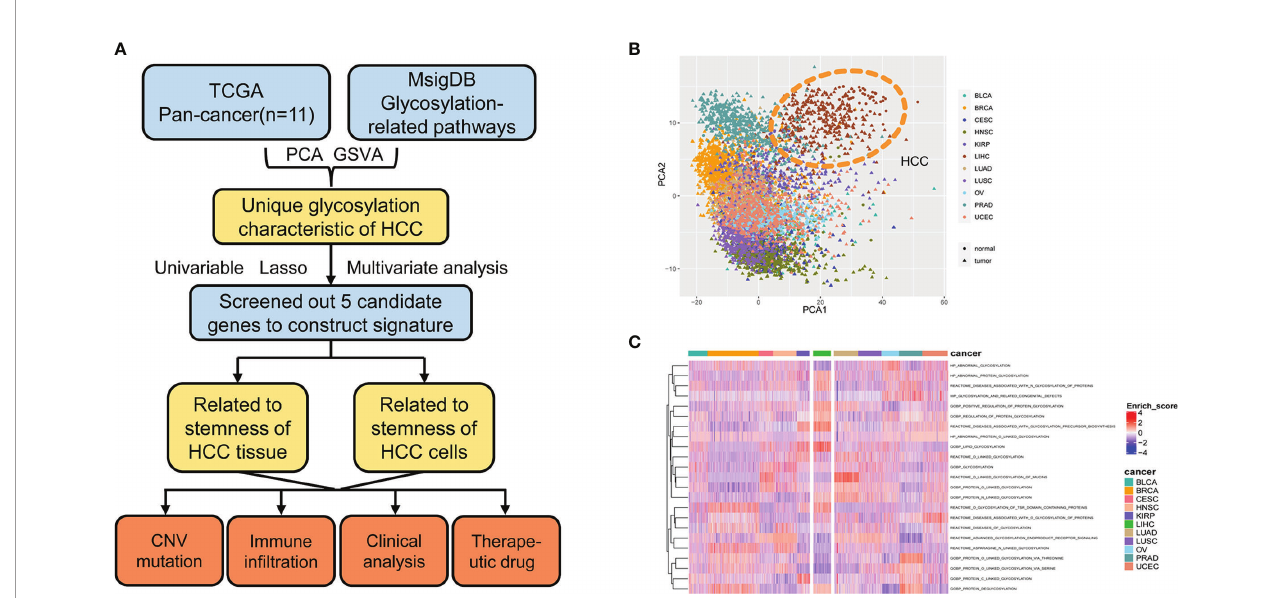
FIGURE 1 | Glycosylation alterations in human pan-cancer. (A) Study fl owchart. (B) PCA projection of paired tumor and normal tissue samples from 11 different cancer types in TCGA. Different colors represent different cancer types. Circles and triangles represent normal and tumor tissue, respectively. (C) Heatmap showing glycosylation-related pathway alterations across 11 cancer types. MsigDB, molecular signatures database; PCA, principal component analysis; HCC, hepatocellular carcinoma; GSVA, gene set variance analysis; CNV, copy number variation; BLCA, bladder urothelial carcinoma; BRCA, breast invasive carcinoma; CESC, cervical squamous cell carcinoma and endocervical adenocarcinoma; HNSC, head and neck squamous cell carcinoma; KIRP, kidney renal papillary cell carcinoma; LIHC, liver hepatocellular carcinoma; LUAD, lung adenocarcinoma; LUSC, lung squamous cell carcinoma; OV, ovarian serous cystadenocarcinoma; PRAD, prostate adenocarcinoma; UCEC, uterine corpus endometrial